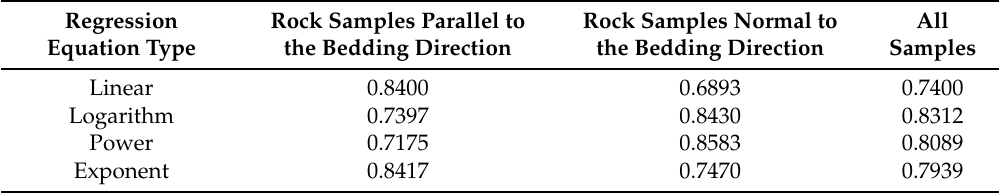
Table 3. The correlation coefficients of different regression equations for rock